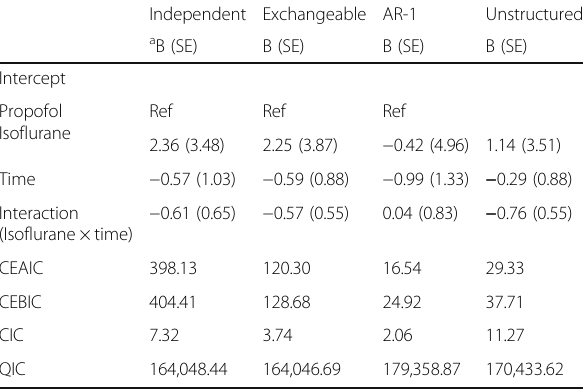
Table 4 Results of fitting GEE model, EAIC, and EBIC criteria for HR outcome